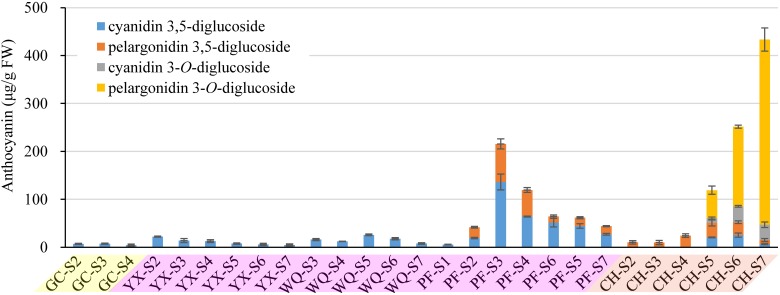
Contents of anthocyanins (detection at 520 nm) extracted from petals of rose cultivars at different developing stages. Data represent the means of three biological replicates ± SD. Because there was no anthocyanins detected in petals of YI throughout the flower development, so the graph present only five cuntivars.